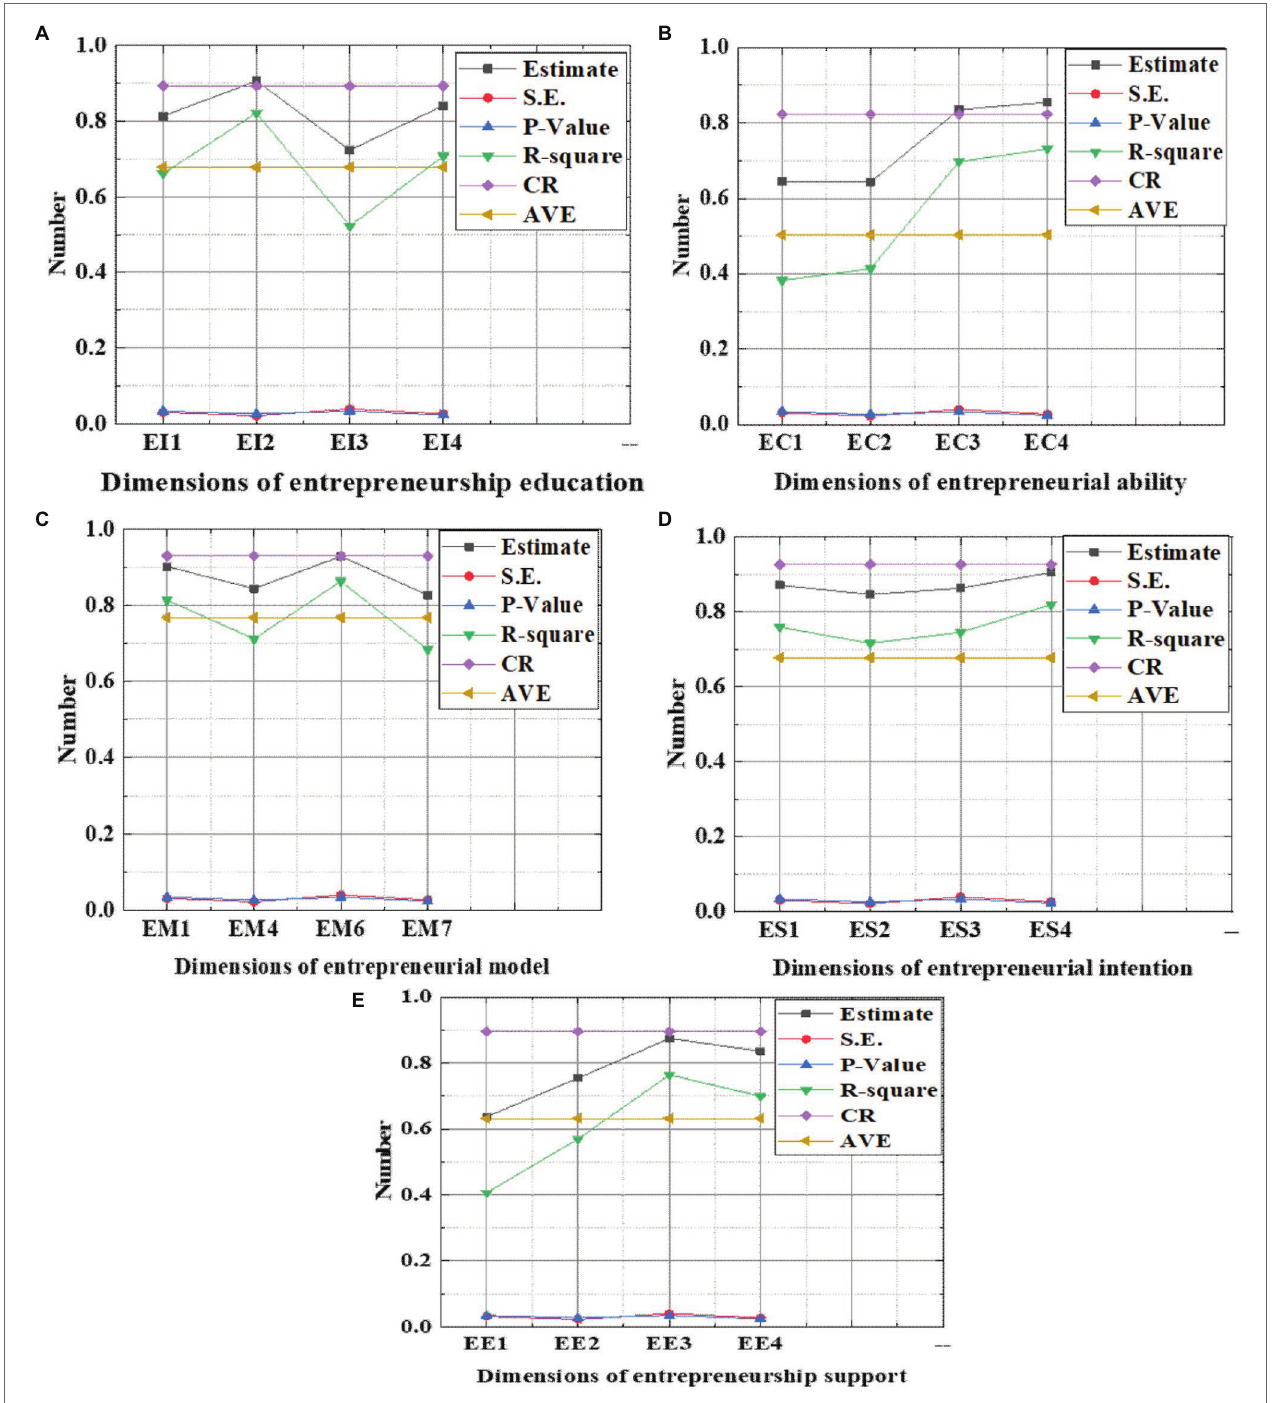
FIGURE 7 | Reliability of each dimension (CR: constituent reliability; AVE: convergent validity; and S.E.: regression standard deviation). ( A : entrepreneurship education; B : entrepreneurial ability; C : entrepreneurial model; D : entrepreneurial intention; and E : entrepreneurial